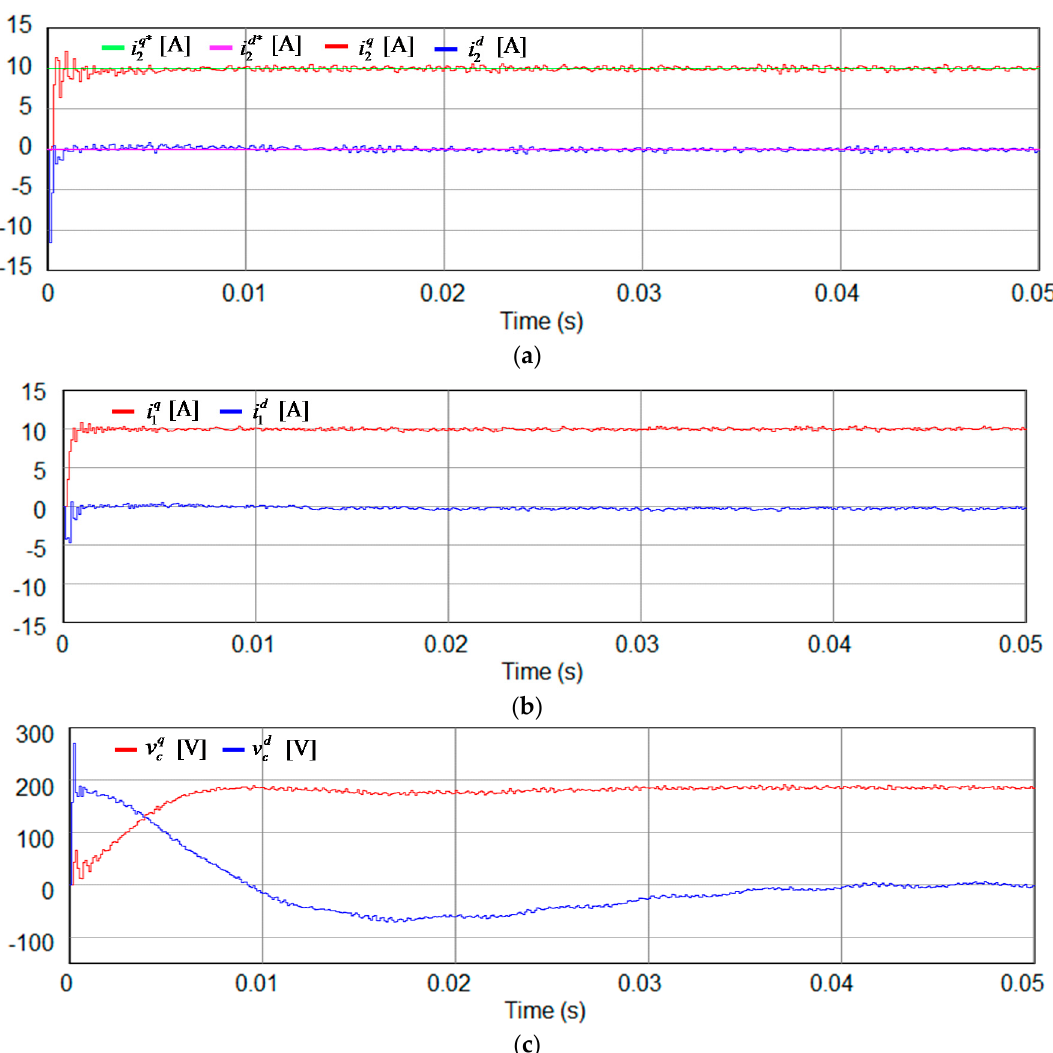
Figure 5. Simulation results for the proposed discrete-time integral state feedback control scheme with state observer. ( a ) Current references and grid-side current responses at the SRF; ( b ) Inverter-side current responses at the SRF; ( c ) Capacitor voltage responses at the SRF.